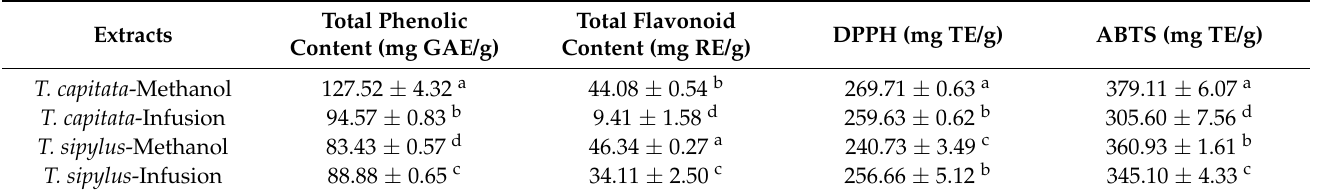
Table 1. Total bioactive compounds and radical scavenging ability of the tested